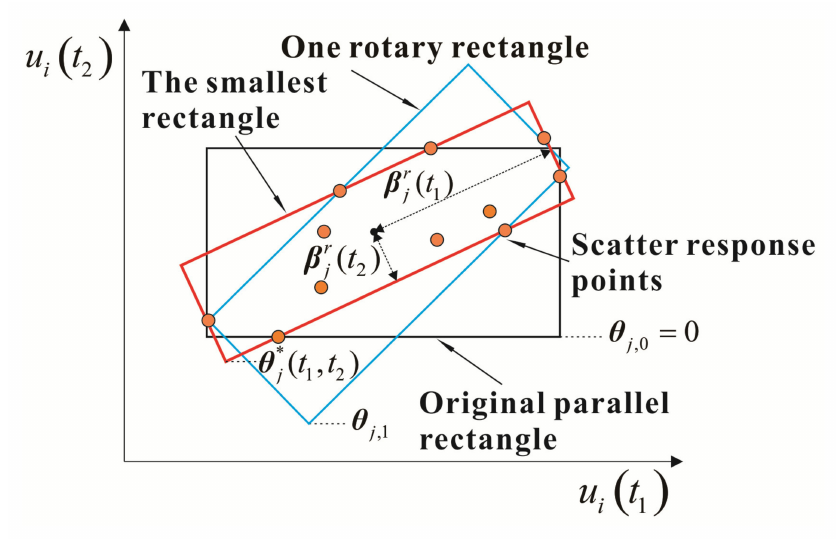
Figure 1. The novel optimization-based strategy for determination of the smallest rotary rectangular